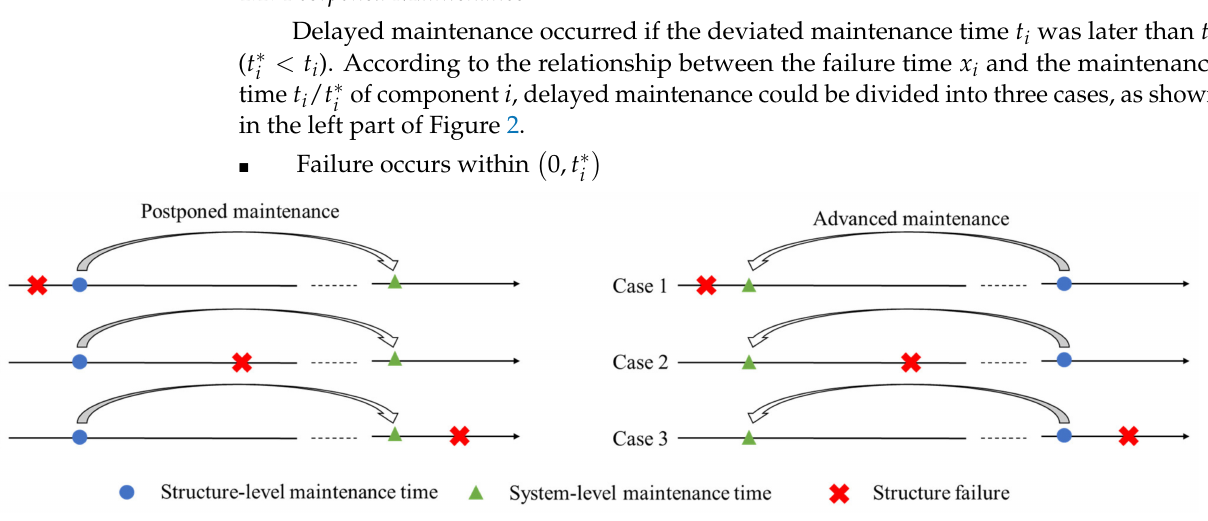
Figure 2. Illustrations of postponed maintenance ( left ) and advanced maintenance ( right